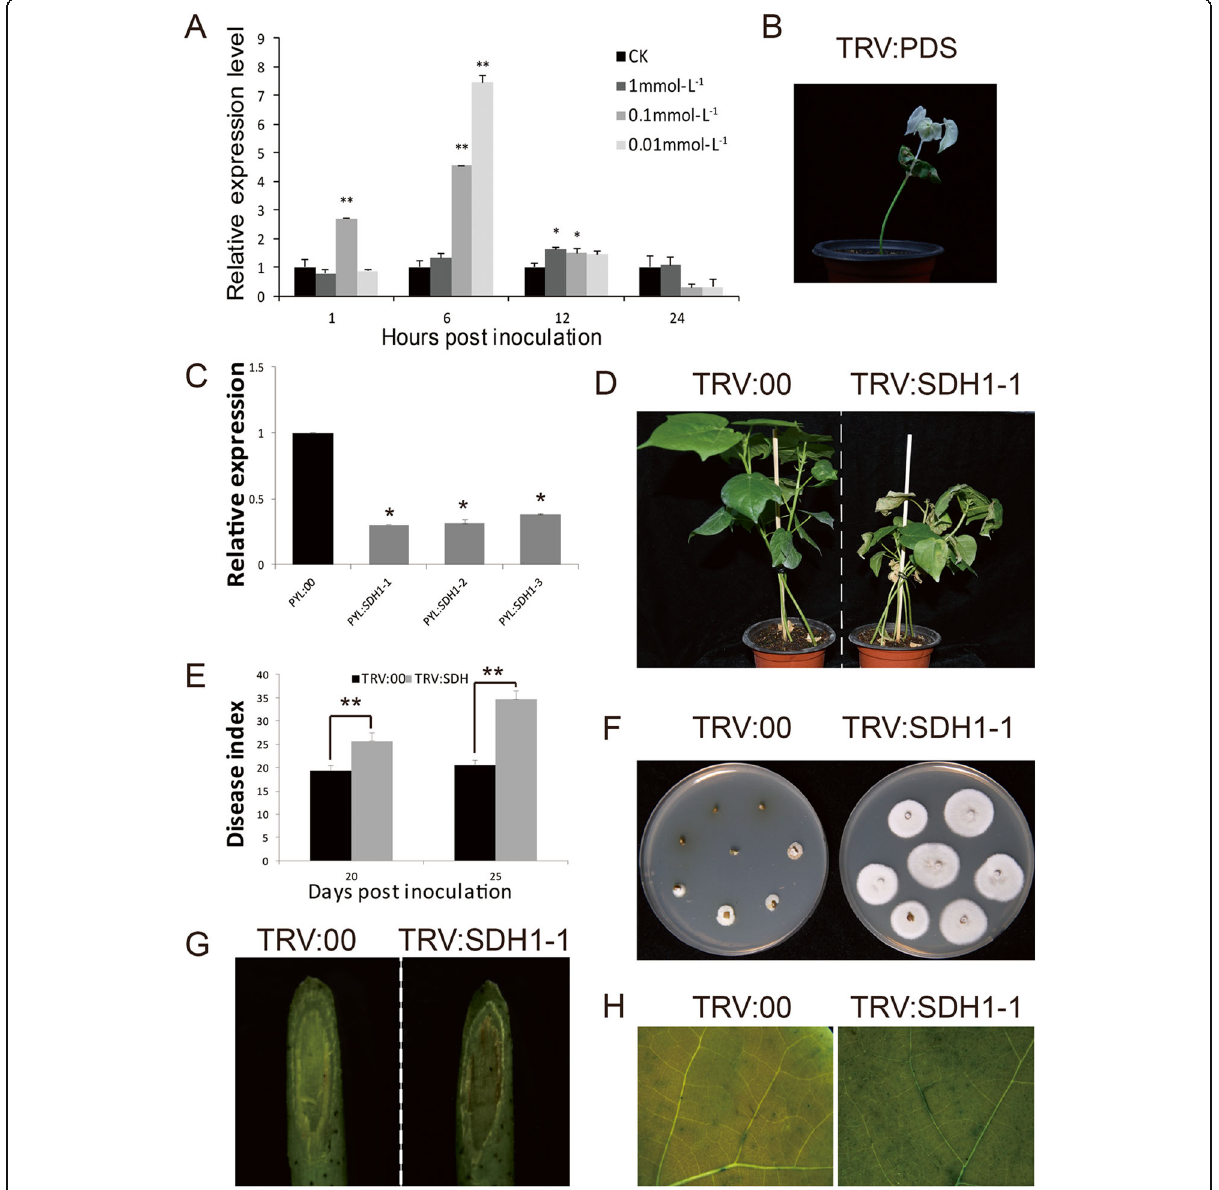
Fig. 2 a GhSDH 1-1 expression pattern in hormone (SA)-treated ‘ Zhongzhimian 2 ’ plants. a , Treatment with exogenous hormone SA (1 mmol·L -1 , 0.1 mmol·L -1 , 0.01 mmol·L -1 ) or an equal amount of sterile water. Mimetics and treated roots were harvested at 1, 6, 12, 24 hpi, respectively,